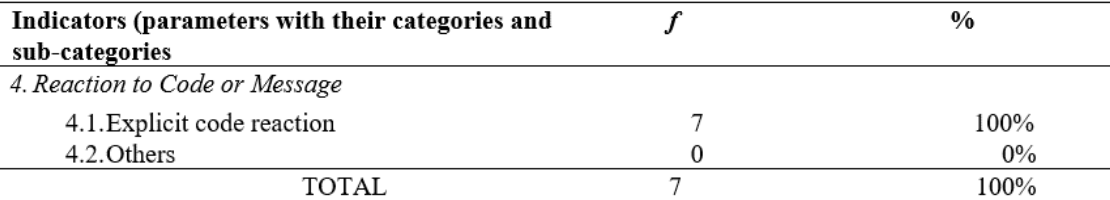
Table 5. Reaction to Code or